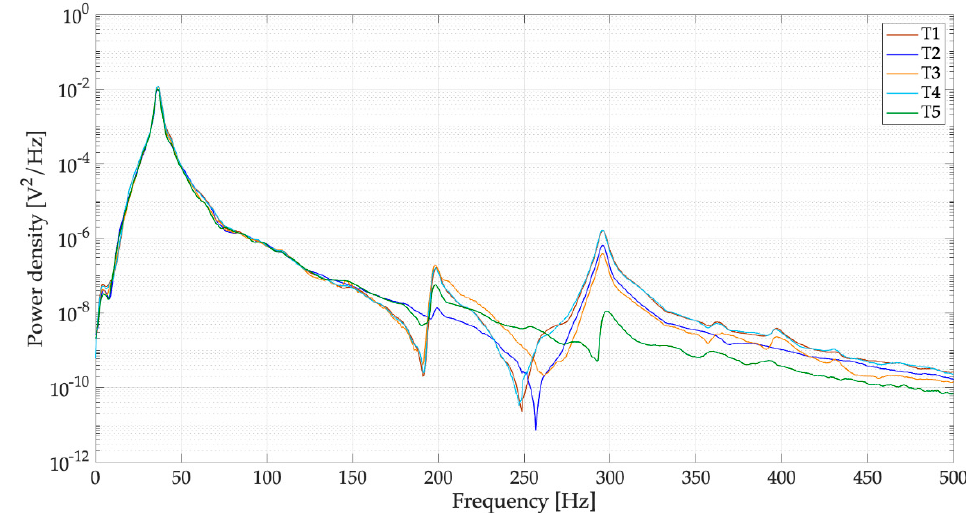
Figure 12. Tests with drops falling from 1 m on the filled spoon, power spectral densities (PSDs) of open-circuit